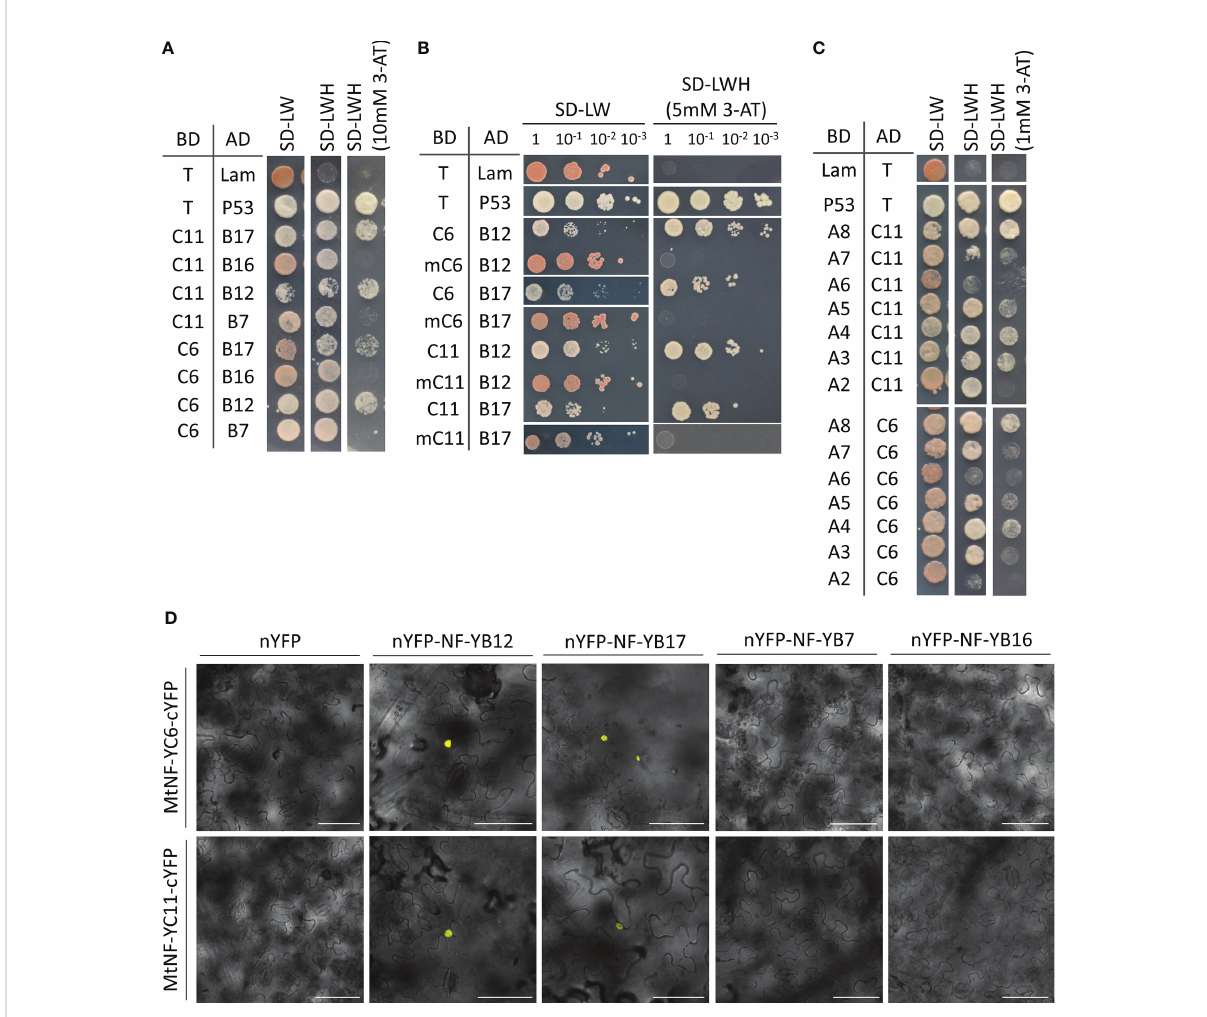
FIGURE 1 Identi fi cation of the interacting partners of MtNF-YC6 and MtNF-YC11 using yeast two-hybrid and BiFC assays. (A) Interaction of MtNF-YC6 (C6) or MtNF-YC11 (C11) with four different MtNF-YBs (B7, B12, B16, and B17). (B) Interaction of wild type or mutated MtNF-YC6 (mC6) and MtNF- YC11 (mC11) either with MtNF-YB12 (B12) or MtNF-YB17 (B17). (C) Interaction of MtNF-YC6 or MtNF-YC11 with seven different MtNF-YAs. Interactions of T with p53 and Lam were used as a positive and negative control, respectively. BD, Gal4 binding domain. AD, Gal4